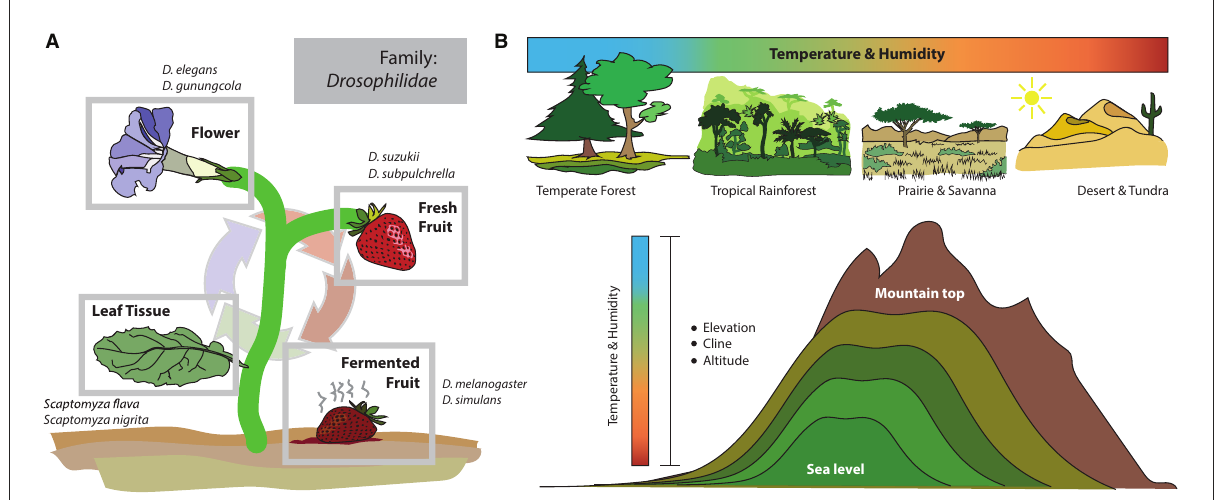
FIGURE1 Ecology and habitat use within the Drosophila genus. (A) The most well-studied species, Drosophila melanogaster , and its closest relatives, primarily utilize fermenting fruit and sites of heavy bacteria and yeast growth. Therefore, this genus is often known as fruit flies (or vinegar flies). However, within this family and genus (Drosophilidae: Drosophila ), there are species that target more diverse host resources, including flowers, fresh/ripening fruits, and even leaf tissues. But how the sensory systems of each new species evolve, and the mechanisms for that adaptation are less well-known. (B) Members of the Drosophila genus are found across a multitude of ecological zones and habitats, including very different environments regarding temperature and humidity, as well as altitude and light availability. This makes the genus an ideal model for studying adaptation to new habitats (and microhabitats), including how sensory systems and the brain change in order to maximize evolutionary success in each new ecological